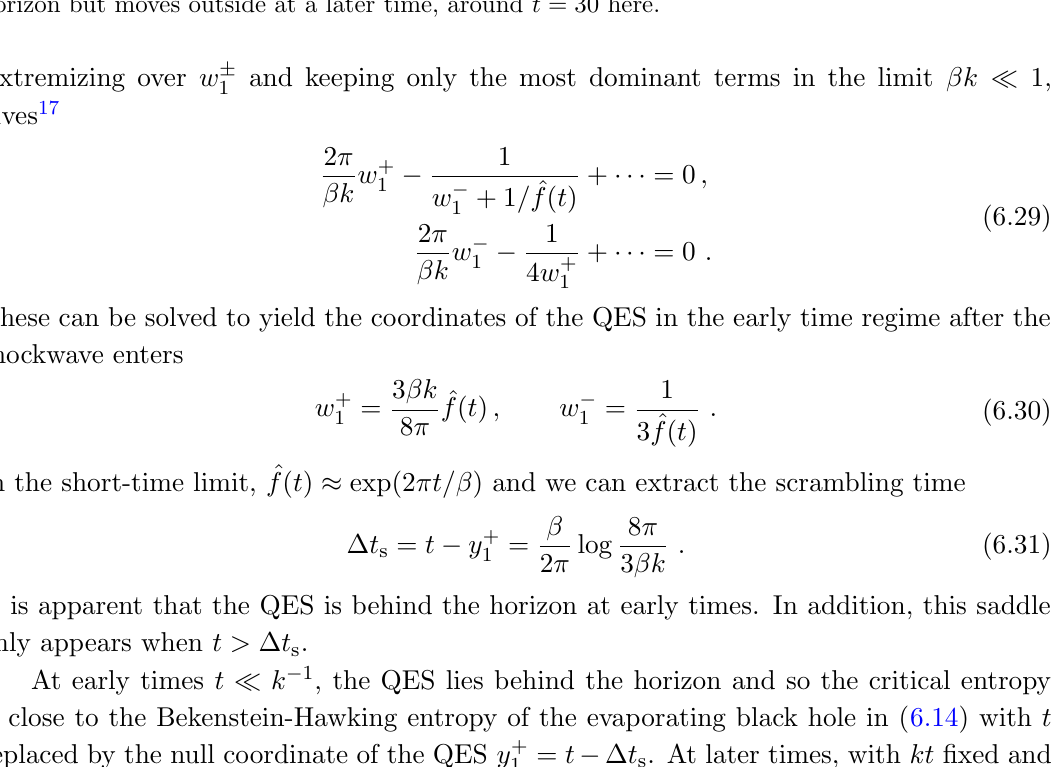
Figure 11 . Left : the Page curve, with the saddle with the QES in front/behind the shockwave in black/red. Right : the w (cid:0) coordinate of the QES as a function of time. The QES starts behind the 1 horizon but moves outside at a later time, around t = 30